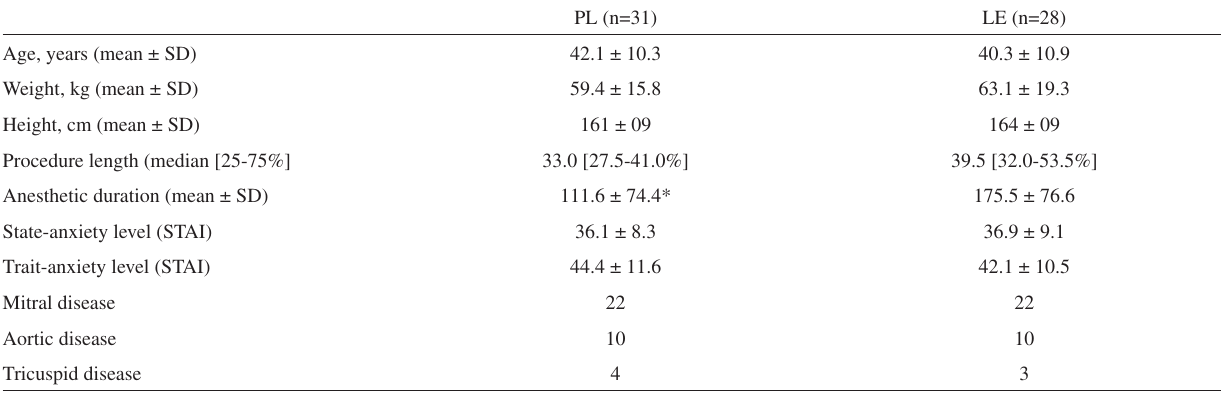
Table 1 - Demographic data, procedure and anesthetic length, STAI results and valvular disease distribution